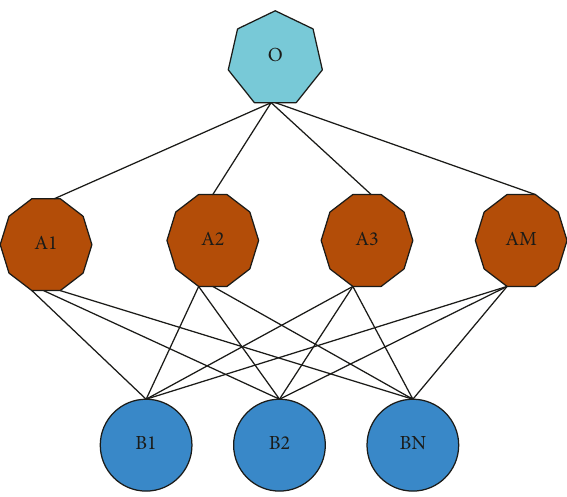
Figure 2: Building a hierarchical total sorting